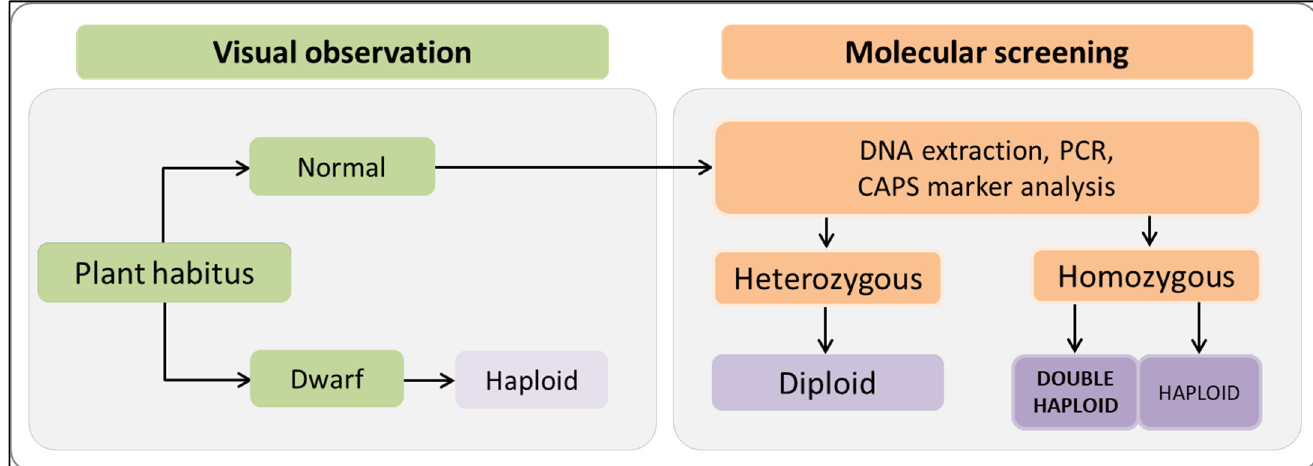
Figure 8. Combined approach of visual observation and molecular screening to discriminate haploid, doubled haploid, and diploid androgenic individuals. Adopted plants were grown in soil mixture and were inspected visually for dwarf habitus. In second phase, normal individuals were subjected to molecular analysis by a CAPS marker to discriminate zygotic state of L4 allele for PMMoV resistance.